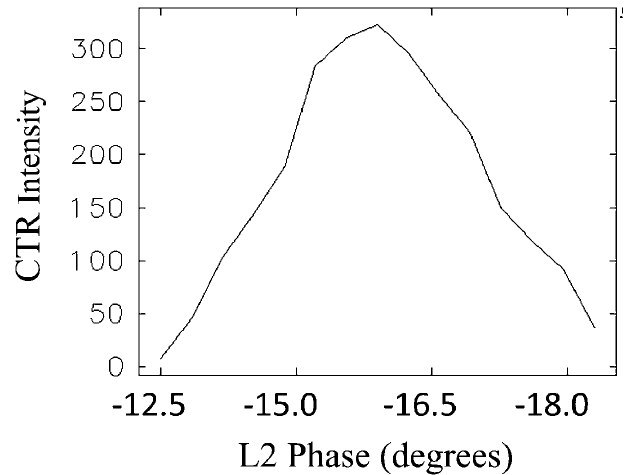
FIG. 4. FIR CTR signal from the Golay cell variation with the upstream L2 phase